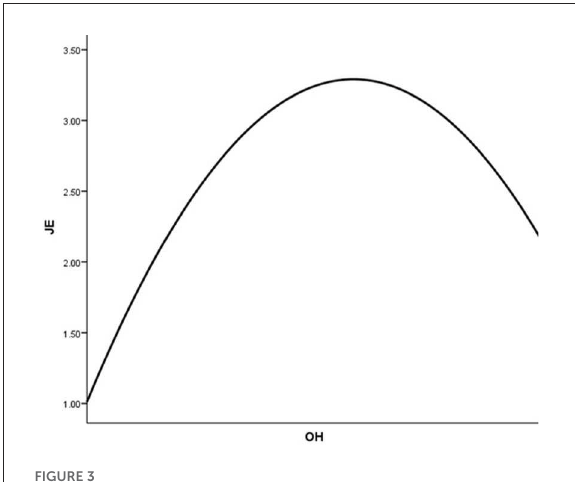
FIGURE3 Curvilinear relationship between JE and